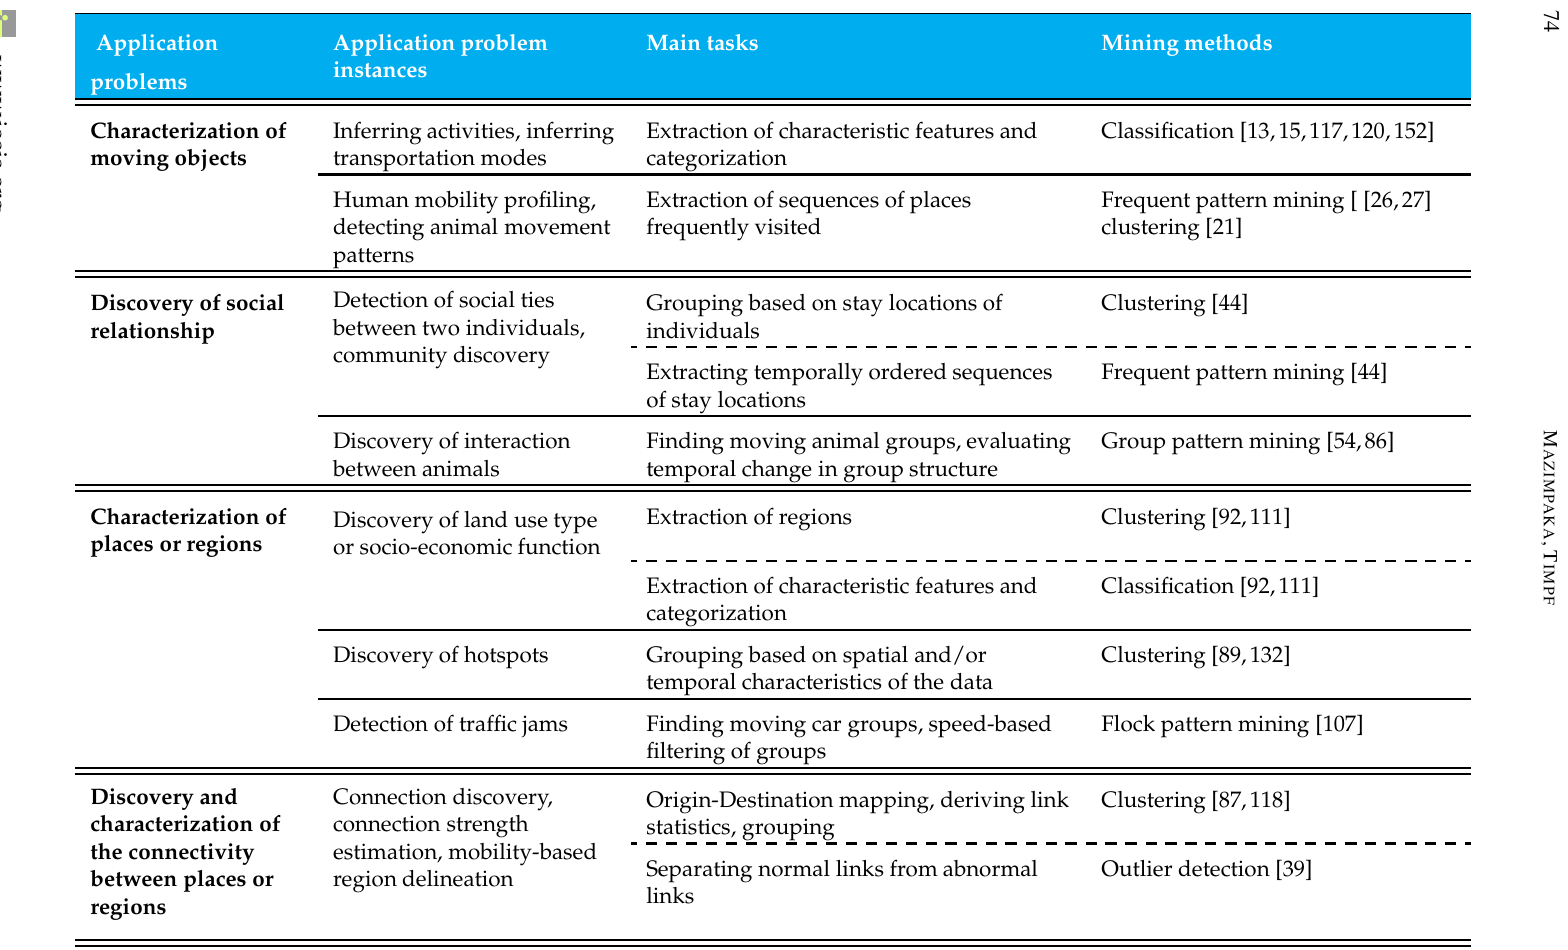
Table 2: Trajectory mining application problems and corresponding